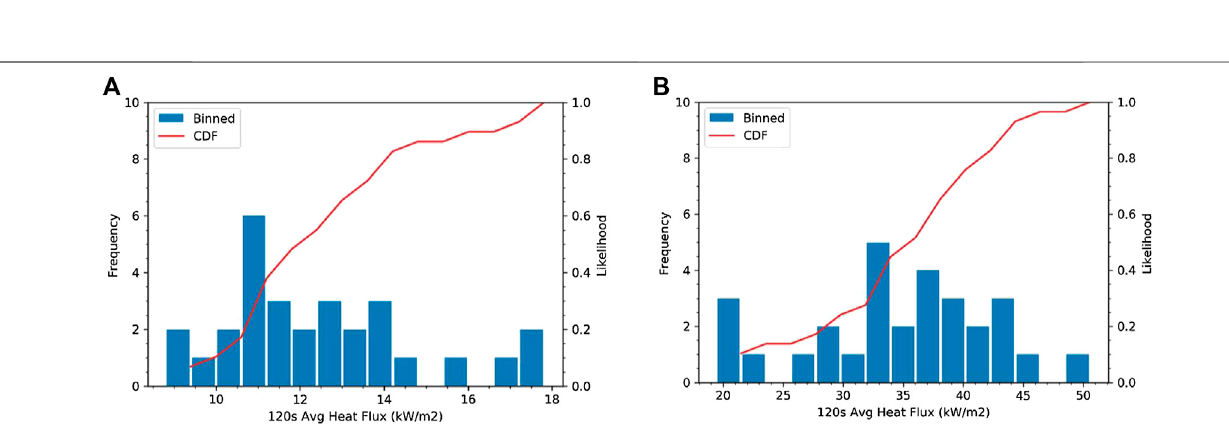
Frontiers in Mechanical Engineering |